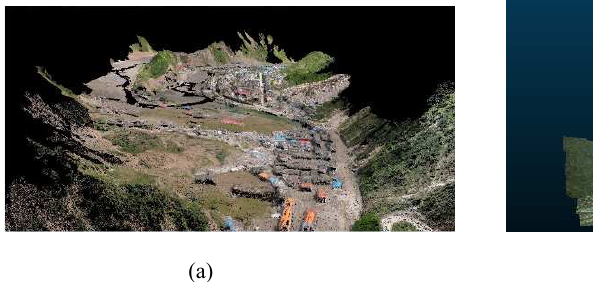
Figure.2 3D point cloud of Beichuan. (a) pre-disaster